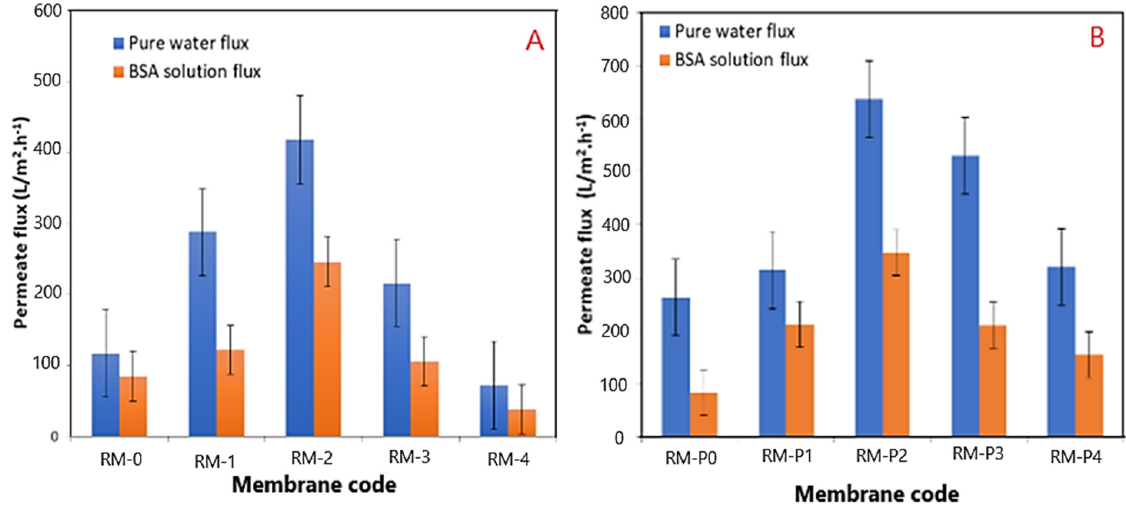
Figure 13. ( A ) Effects of GO − WO 2.89 loading on PPSU membrane on pure water and BSA solution permeate flux; ( B ) effects of GO − WO 2.89 loading on PPSU/PVP membrane on pure water and BSA solution permeate flux.